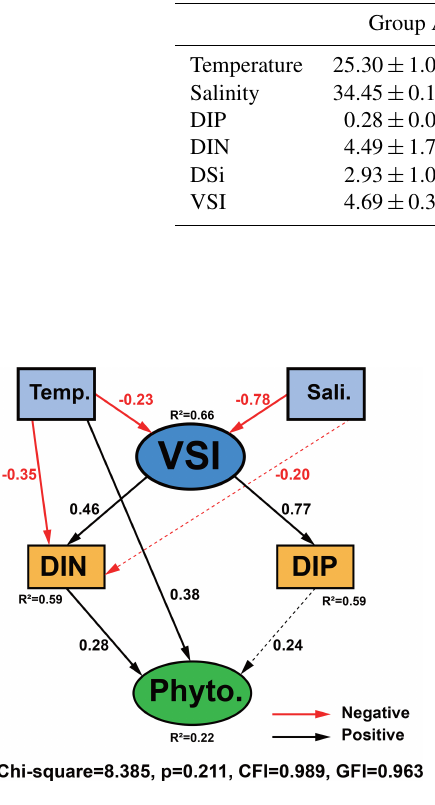
Figure 10. Structural equation model (SEM) analysis examining the effects of temperature, salinity, VSI, DIN, and DIP on phyto- plankton abundance. Solid black and red lines indicate significant positive and negative effects at p < 0 . 05, respectively, and dashed black and red lines indicate insignificant positive and negative ef- fects, respectively. R 2 values associated with response variables in- dicate the proportion of variation explained by relationships with other variables. Values associated with arrows represent standard- ized path